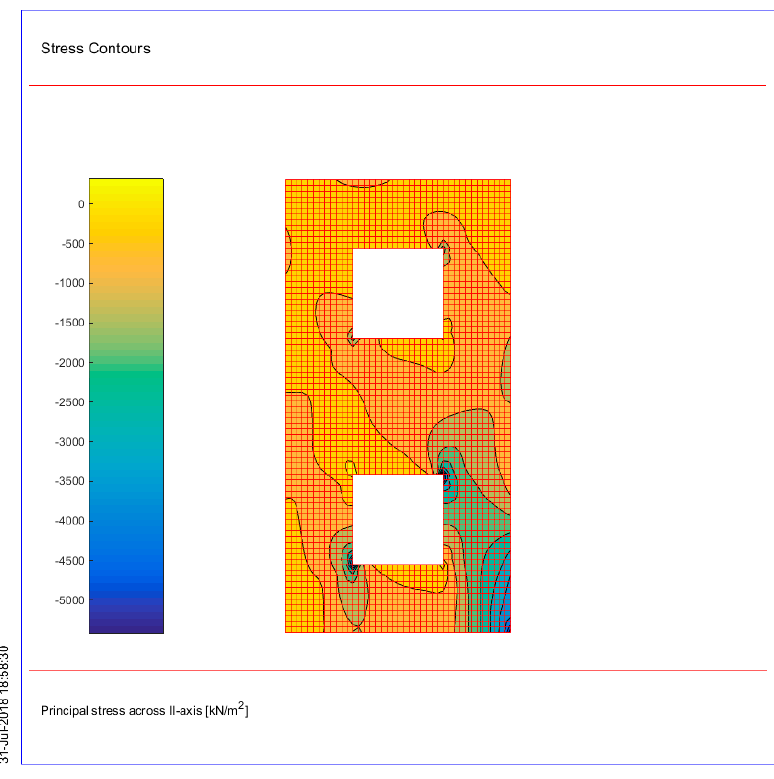
Figure 22. Stress contours of principal stress across II-axis (PGA = 0.40 g).